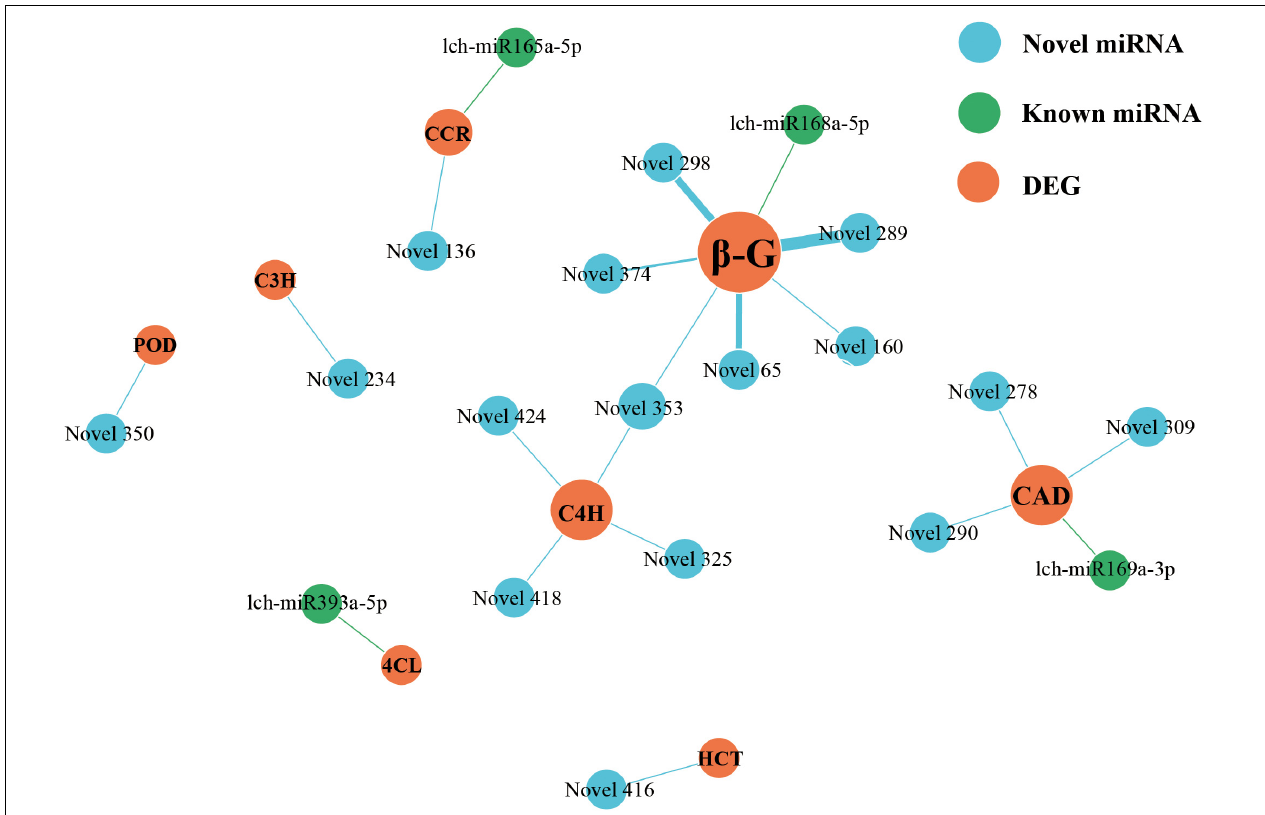
FIGURE 7 | miRNAs-DEGs regulatory network of phenylpropanoid biosynthesis pathway. The size of dot represents the number of DEGs: the larger the dot, the more DEGs. The wider the edge, the more DEGs are targeted by